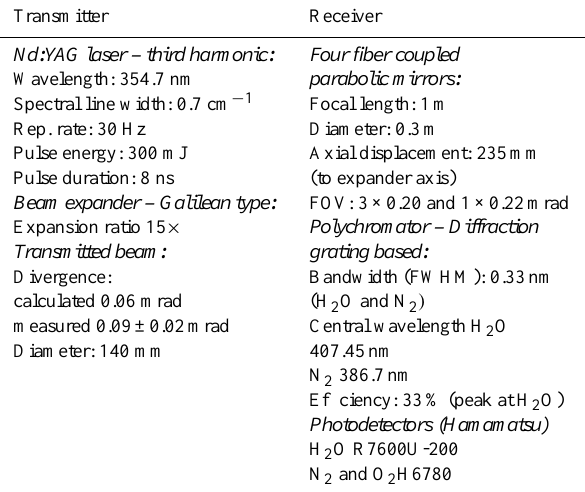
Table 1. System parameters. Transmitter Receiver